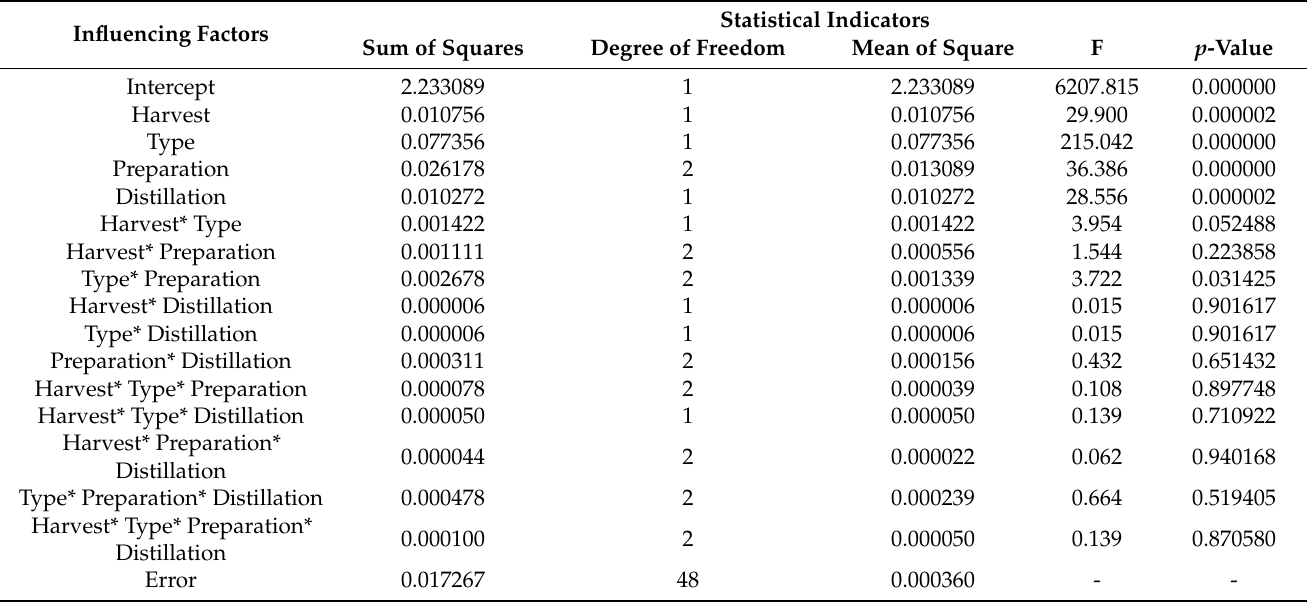
Table 1. Results of the analysis of the variance of the influence of the analyzed factors on the content of the essential oils in immortelle at a significance level of p < 0.05.